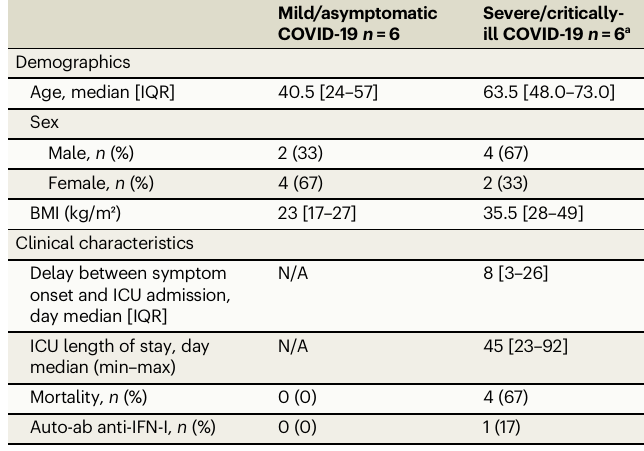
Table 1 | Demographical and clinical characteristics of health care workers (HCWs) with mild/asymptomatic and severe/ critically ill COVID-19